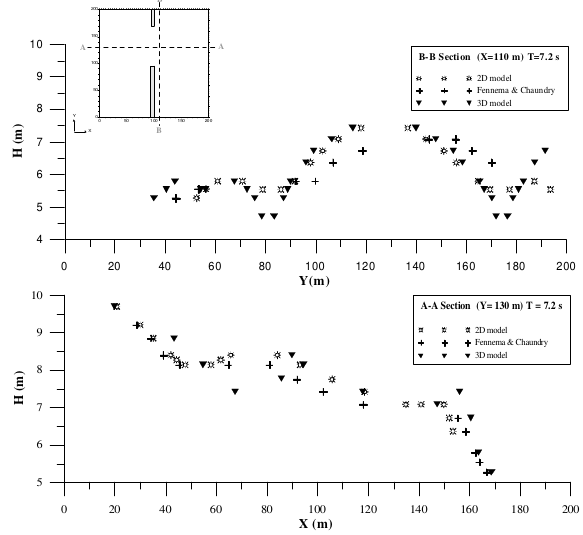
Fig. 4. Water depth at 7.2s after the gate collapse: B-B and A-A